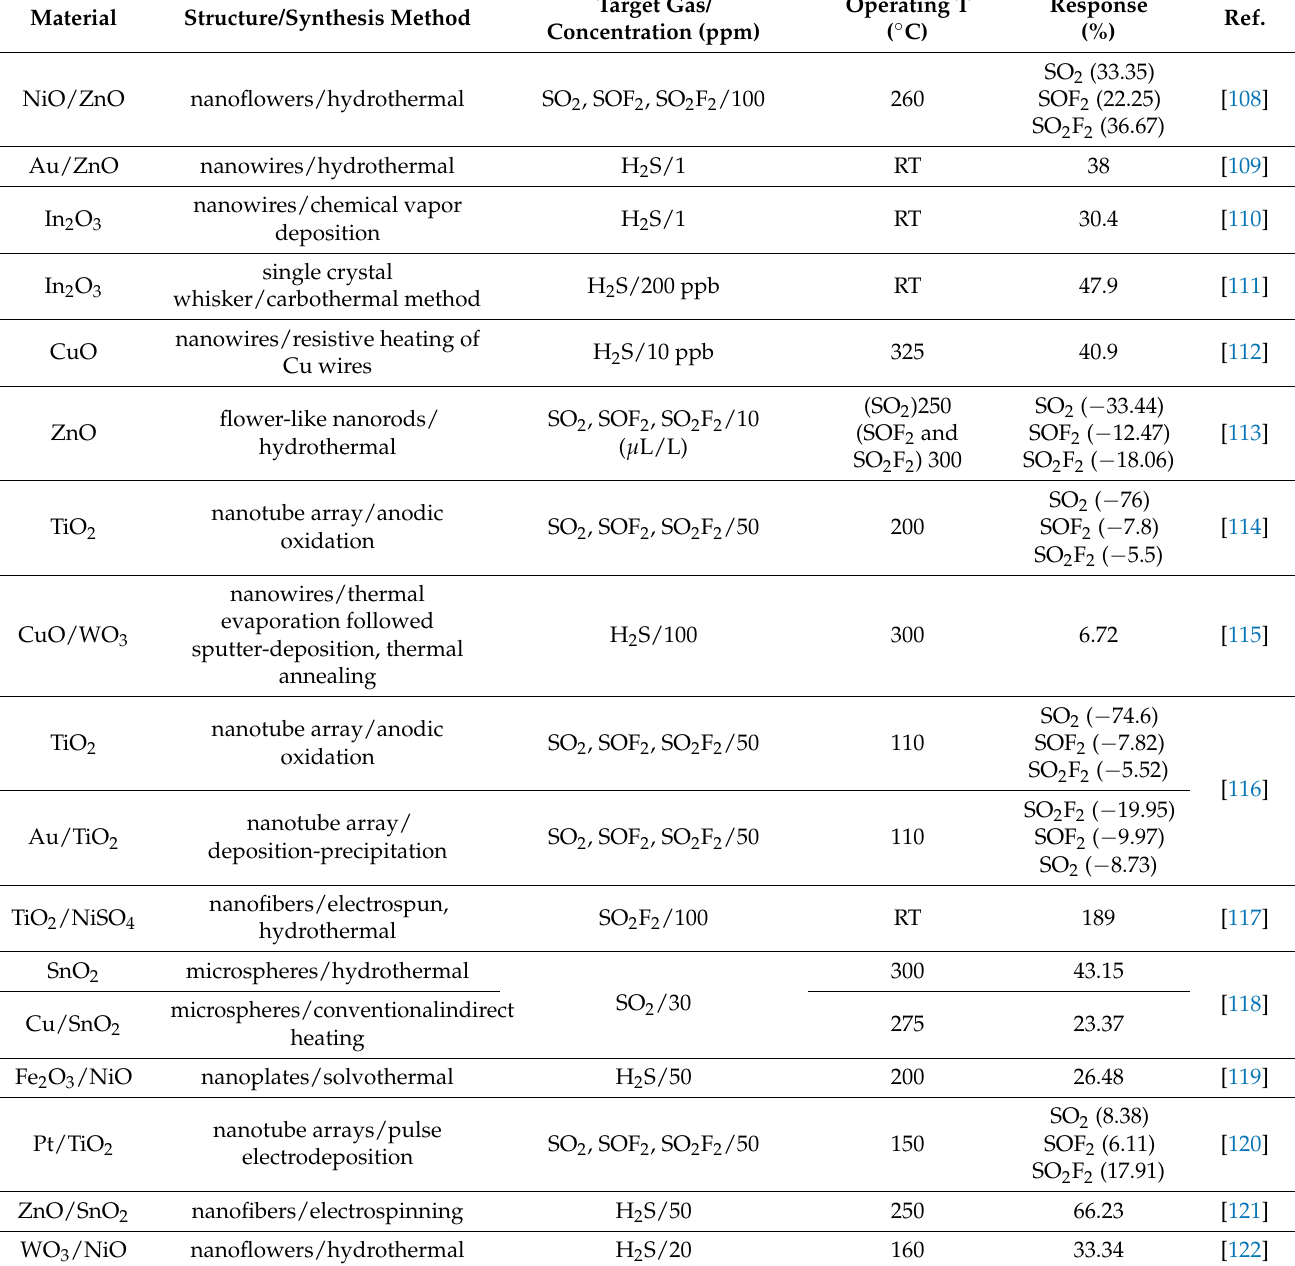
Table 7. Summary of MOX-based sensor towards SF 6 decomposed